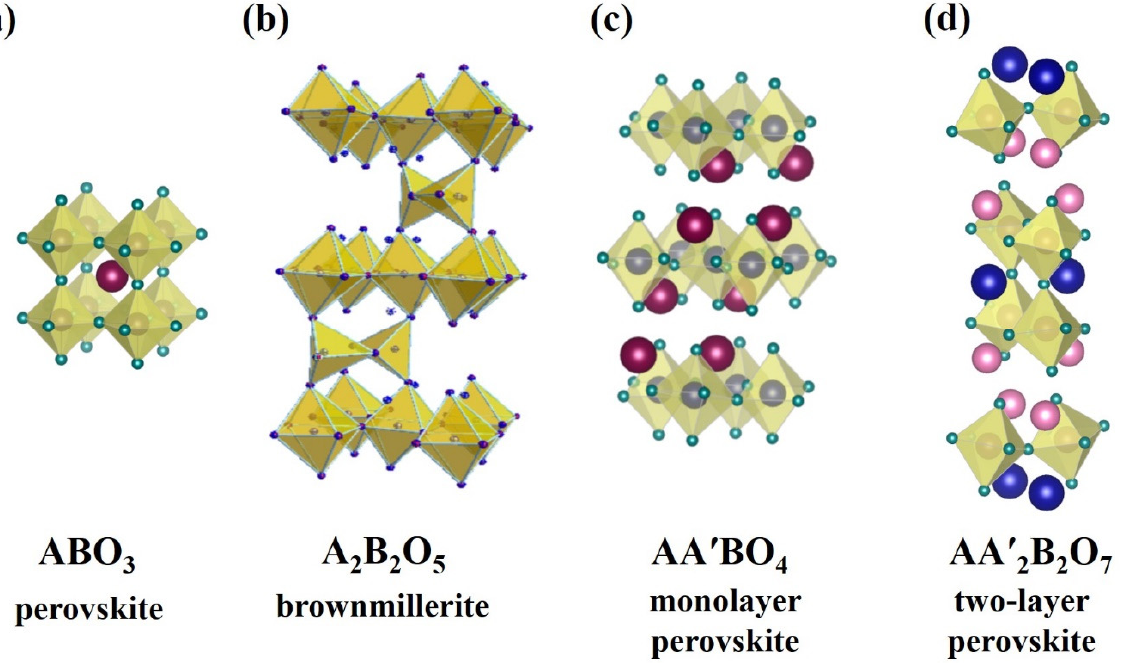
Figure 1. Crystal structures of perovskite ( a ), brownmillerite ( b ), monolayer ( c ) and two-layer ( d ) ( d ) perovskites.